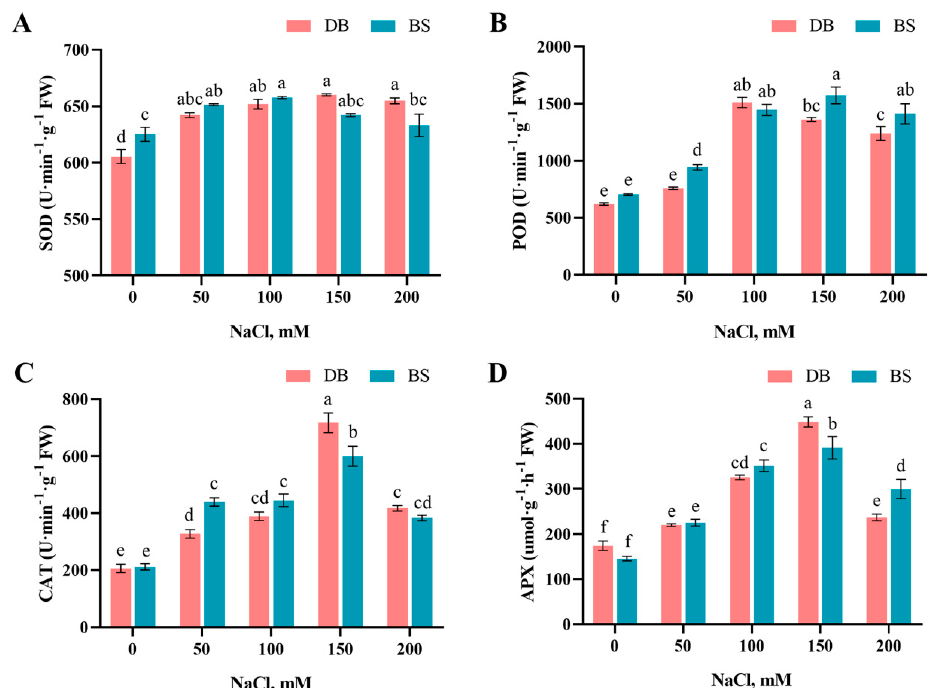
Figure 5. Effect of different NaCl concentrations on ( A ) superoxide dismutase activity (SOD), ( B ) peroxidase activity (POD), ( C ) catalase activity (CAT), and ( D ) ascorbate peroxidase activity (APX) of H. syriacus ‘Duede Brabaul’ (DB) and H. syriacus ‘Blueberry Smoothie’ (BS). According to Duncan’s test, different lowercase letters (a–f) indicate significant differences ( p < 0.05) between different treatments.